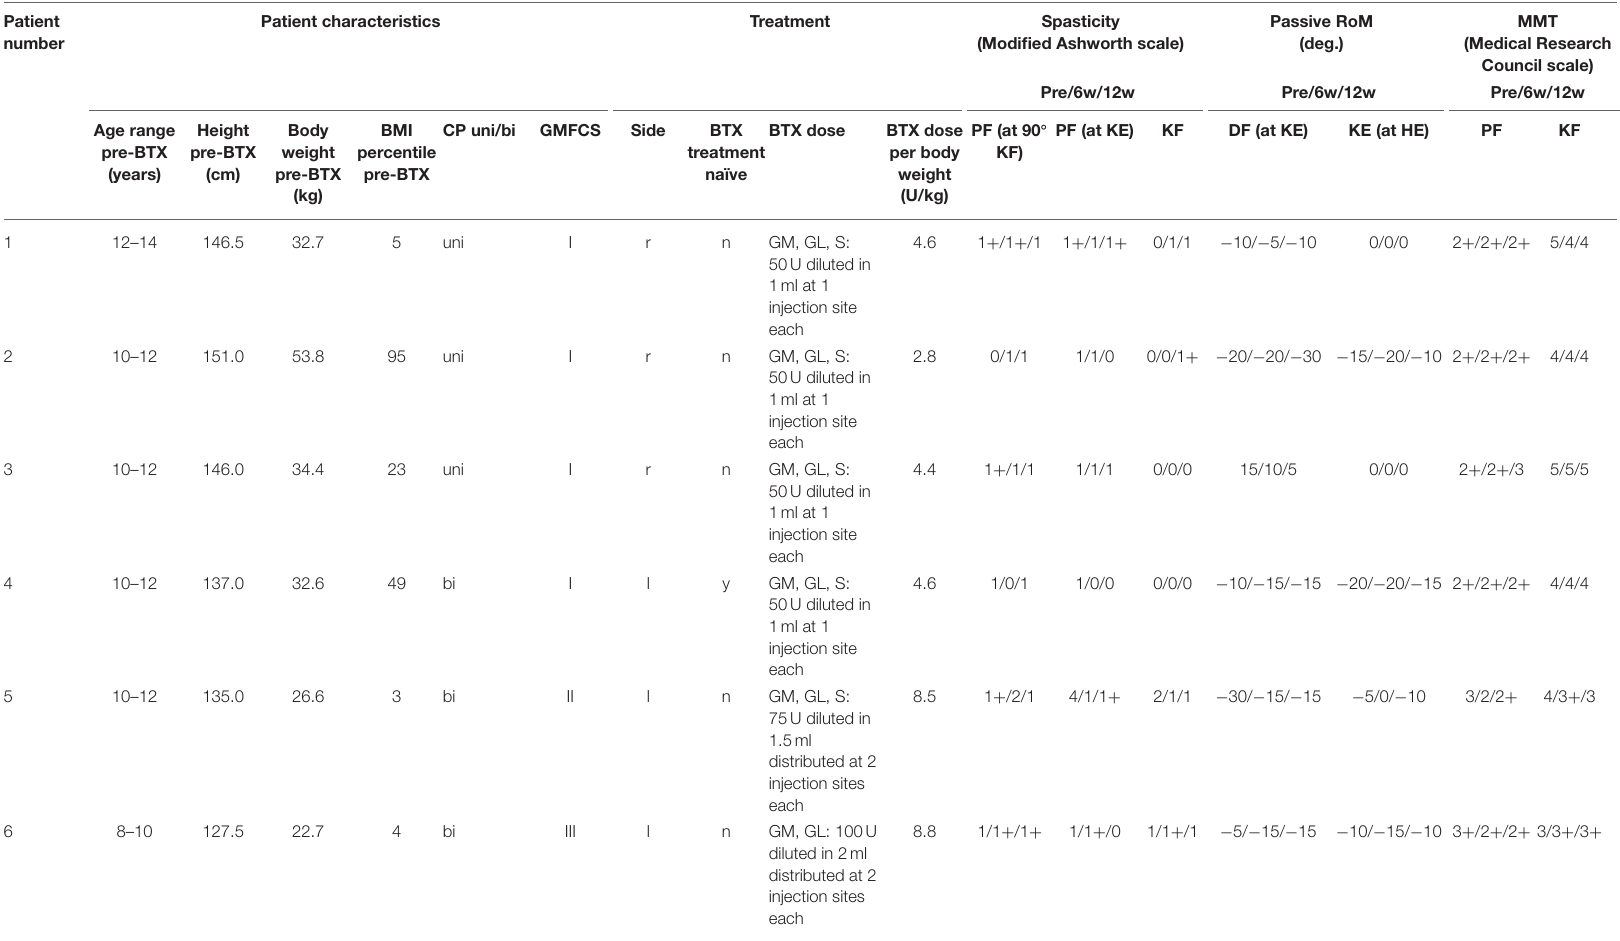
TABLE 1 | Patient characteristics, treatment, and results of the clinical examination pre-BTX, 6 weeks (6w), and 12 weeks (12w) post-BTX showing lower limb spasticity, passive range of motion (RoM), and manual muscle testing (MMT). Patient Patient characteristics Treatment Spasticity number